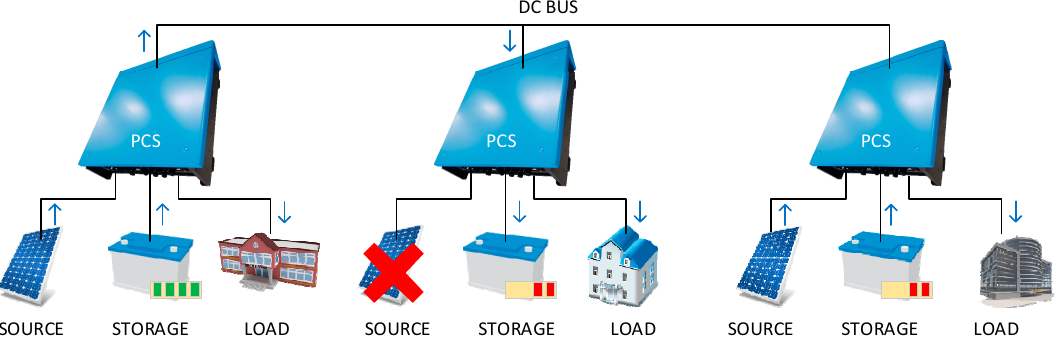
Figure 5. Power flow in multi-point DC microgrid system.